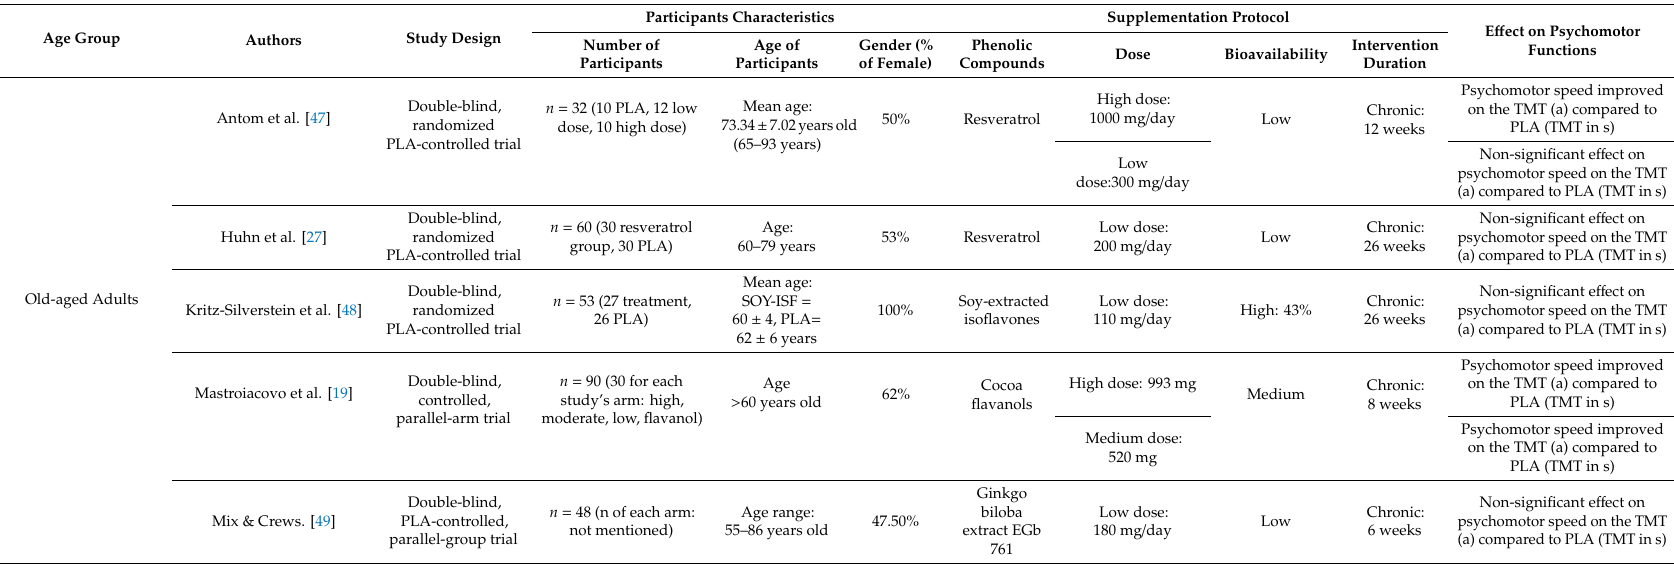
Table 2. E ff ects of (poly)phenols-rich supplementation on psychomotor